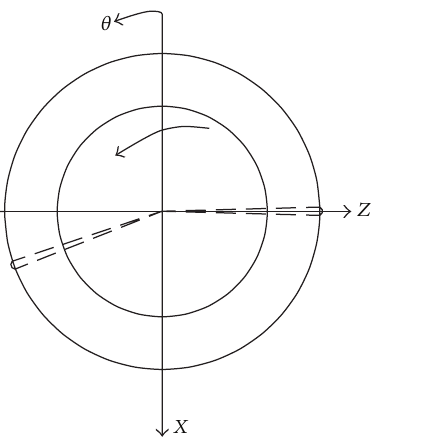
Figure 10: Up-Dn configuration of two-groove oil journal bearing. Table 2: Comparison of nondimensional load values using 10 ∘ , 20 ∘ , and 30 ∘ groove angles.